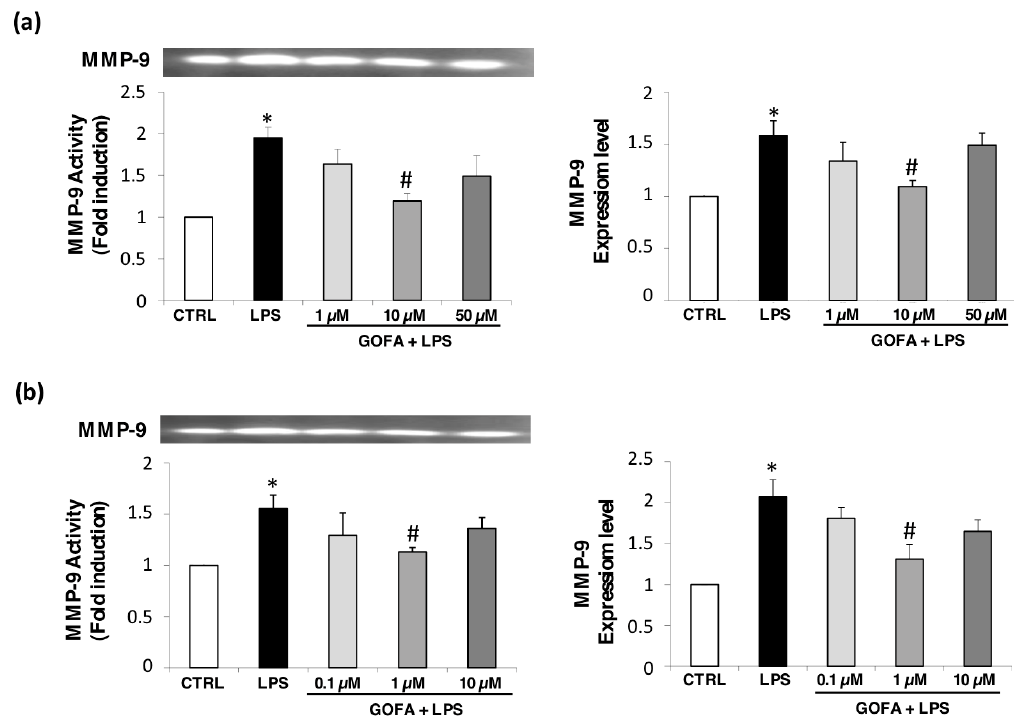
Figure 6. GOFA effects on MMP-9 for U937 ( a ) and HCT-116 ( b ) cell lines. Cell-free conditioned media were assayed for MMP-2 and MMP-9 activity by gelatin zymography. The activity of MMP-9 (92 kDa) (bottom) was reported with fold induction values compared to control MMP-9 activity. Zymogram (top) is representative of 6 gels using 3 separate pools of total protein extracted from cell lines. Changes in MMP-9 gene expression were determined by qRT - PCR assay, using the ( ΔΔ Ct) method and 18S as housekeeping gene. One-way ANOVA, values represent mean ± SD ( n = 6); * p < 0.05 vs control cells; # p < 0.05 vs cell treated with LPS alone .